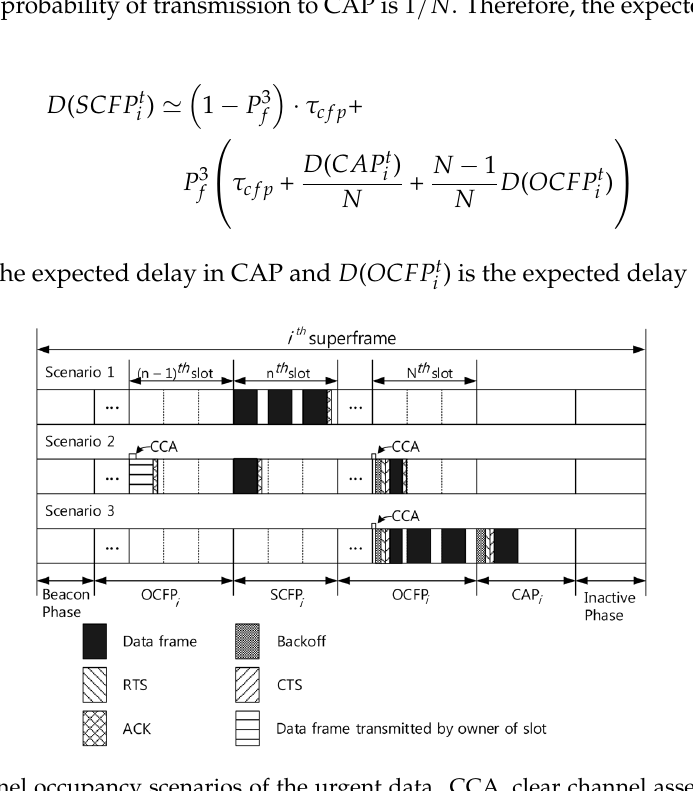
Figure 3. Channel occupancy scenarios of the urgent data. CCA, clear channel assessment; OCFP, opportunistic CFP; SCFP, self